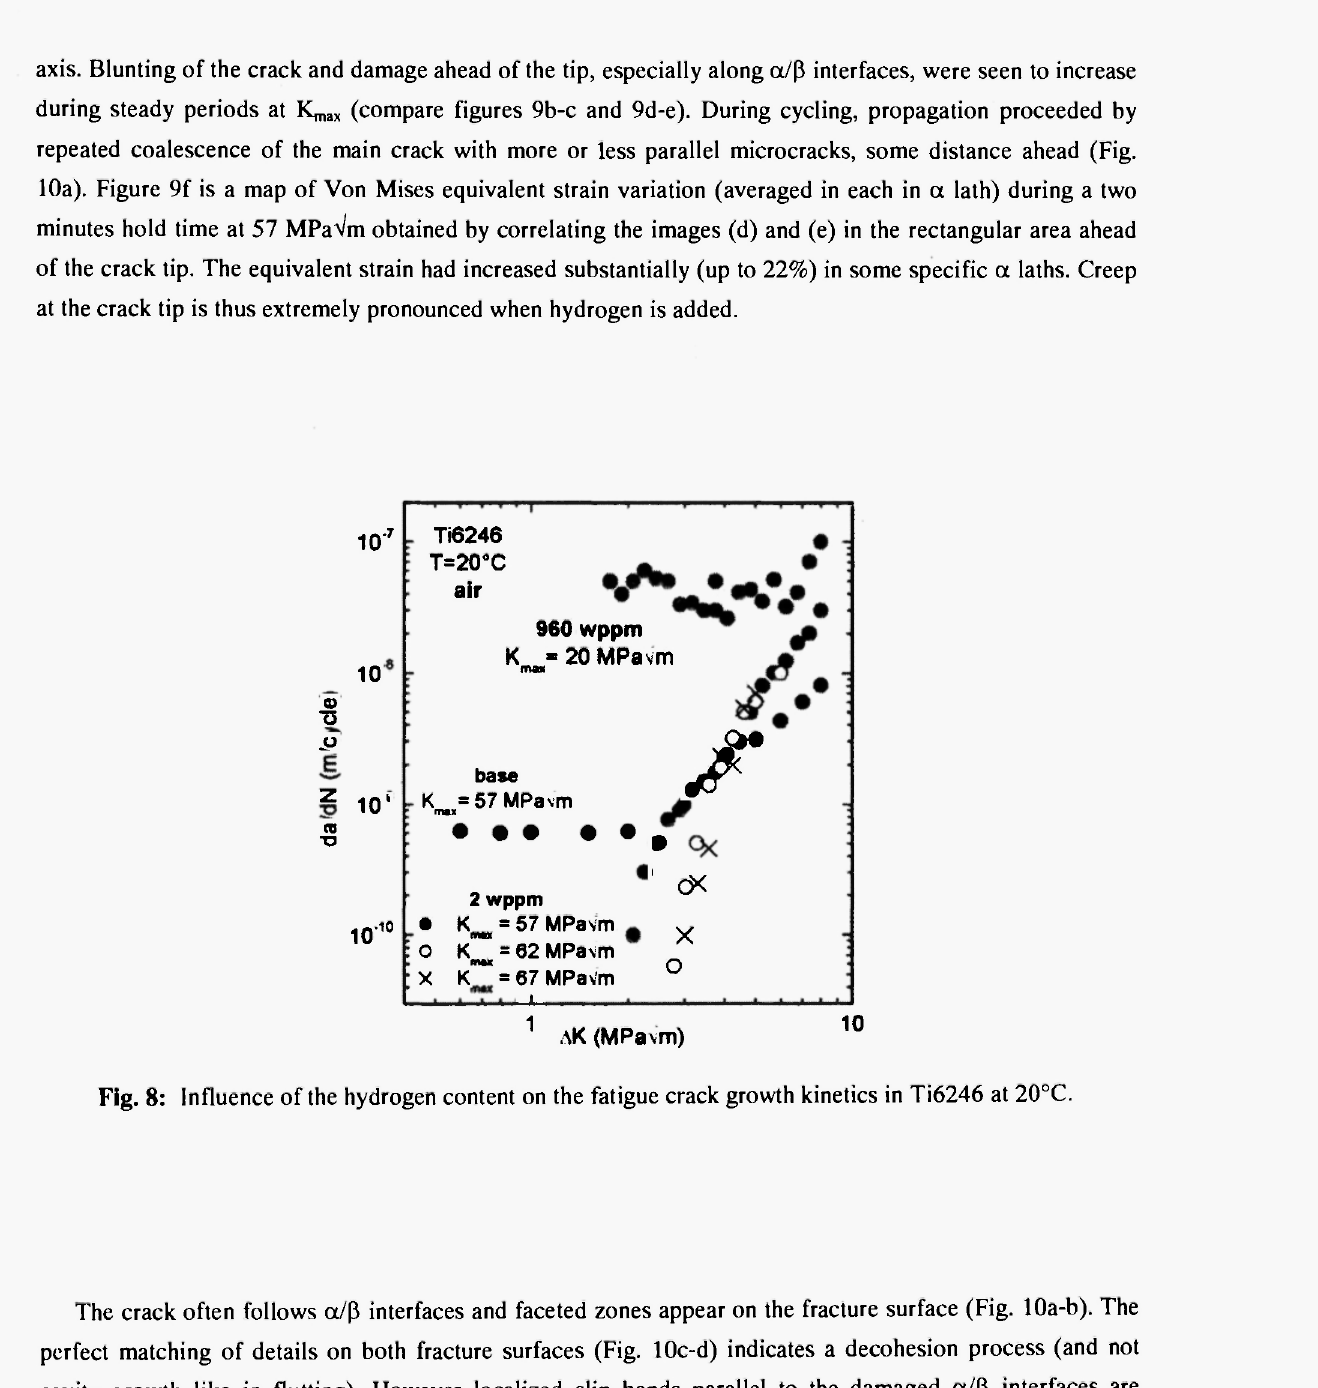
Fig. 8: Influence of the hydrogen content on the fatigue crack growth kinetics in ΤΪ6246 at 20°C.